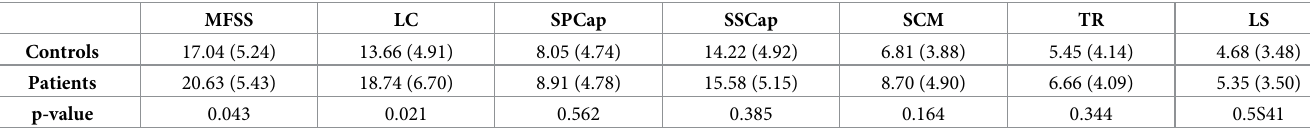
MFSS = multifidus and semispinalis cervicis, LC = longus colli and longus capitis, SSCap = semispinalis capitis, SPCap = splenius capitis, LS = levator scapula, SCM = sternocleidomastoid, TR = trapezius. Mean (SD) and p-values are